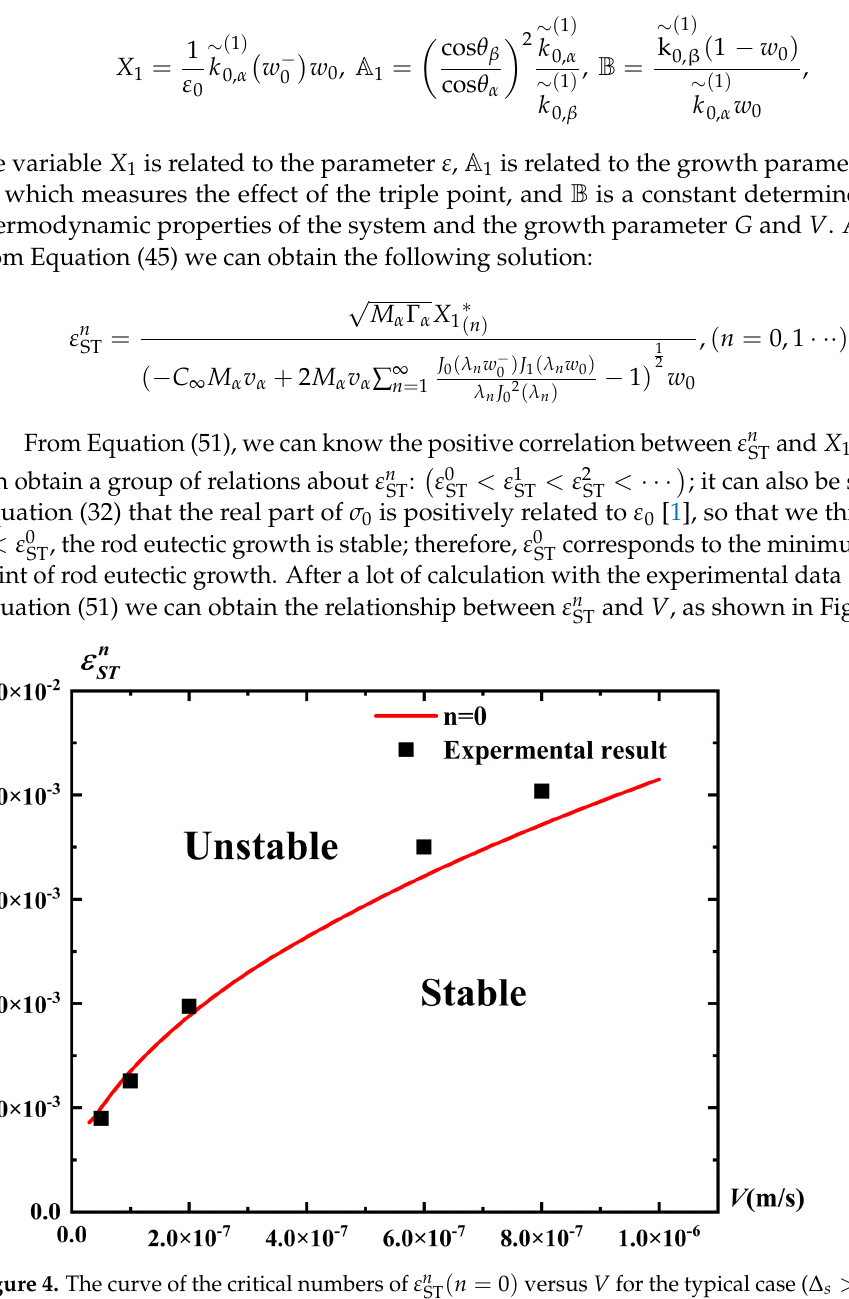
Figure 4. The curve of the critical numbers of ε n θ α = 65 ◦ , θ β = 50.55 ◦ , w 0 = 0.40, G =